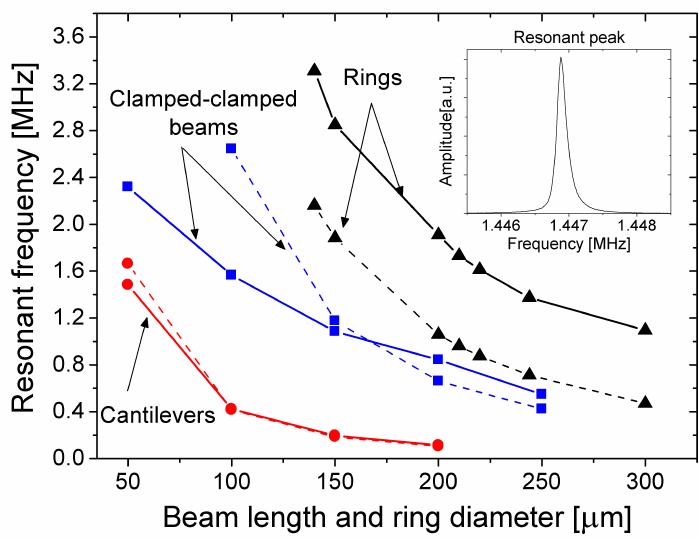
Figure 7. Measured (solid) and theoretical (dashed) dependence of resonant frequency on the structural dimension [27]. c (cid:13) 2012 IEEE. Reprinted, with permission, from Mastropaolo et al. J. Microelectromech. Syst. 21,